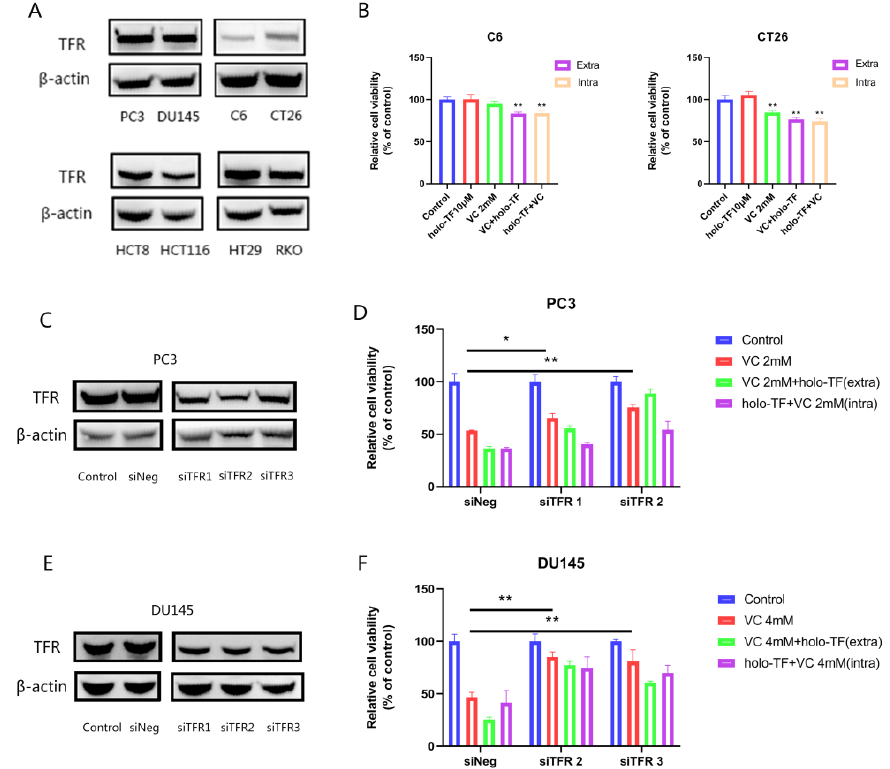
Figure 5. The influence of iron supplementation to VC-induced cytotoxicity is associated with TFR; TFR knockdown attenuates VC-induced cytotoxicity. ( A ) TFR expression of eight cell lines (PC3, DU145, C6, CT26, HCT8, HCT116, HT29 and RKO). ( B ) Relative cell viability of C6 and CT26 cells after being pre-treated with 10 µ M holo-TF for 3 h, washed with PBS and then treated with 2 mM VC for 3 h (iron supplementation intracellular) or co-exposure to 10 µ M holo-TF and 2 mM VC for 3 h (iron supplementation extracellular). ( C , E ) The TFR expression of PC3 and DU145 cells after TFR knockdown after 48 h verified by Western blotting. ( D , F ) Relative cell viability of PC3 and DU145 cells after being pre-treated with 10 µ M holo-TF for 3 h, washed with PBS and then treated with different doses of VC for 3 h (iron supplementation intracellular) or co-exposure to 10 µ M holo-TF and different doses of VC for 3 h (iron supplementation extracellular). The uncropped immunoblot images can be found in Figure S1. The IntDen of western blot bands can be found in Table S1. * p < 0.05, ** p < 0.01.